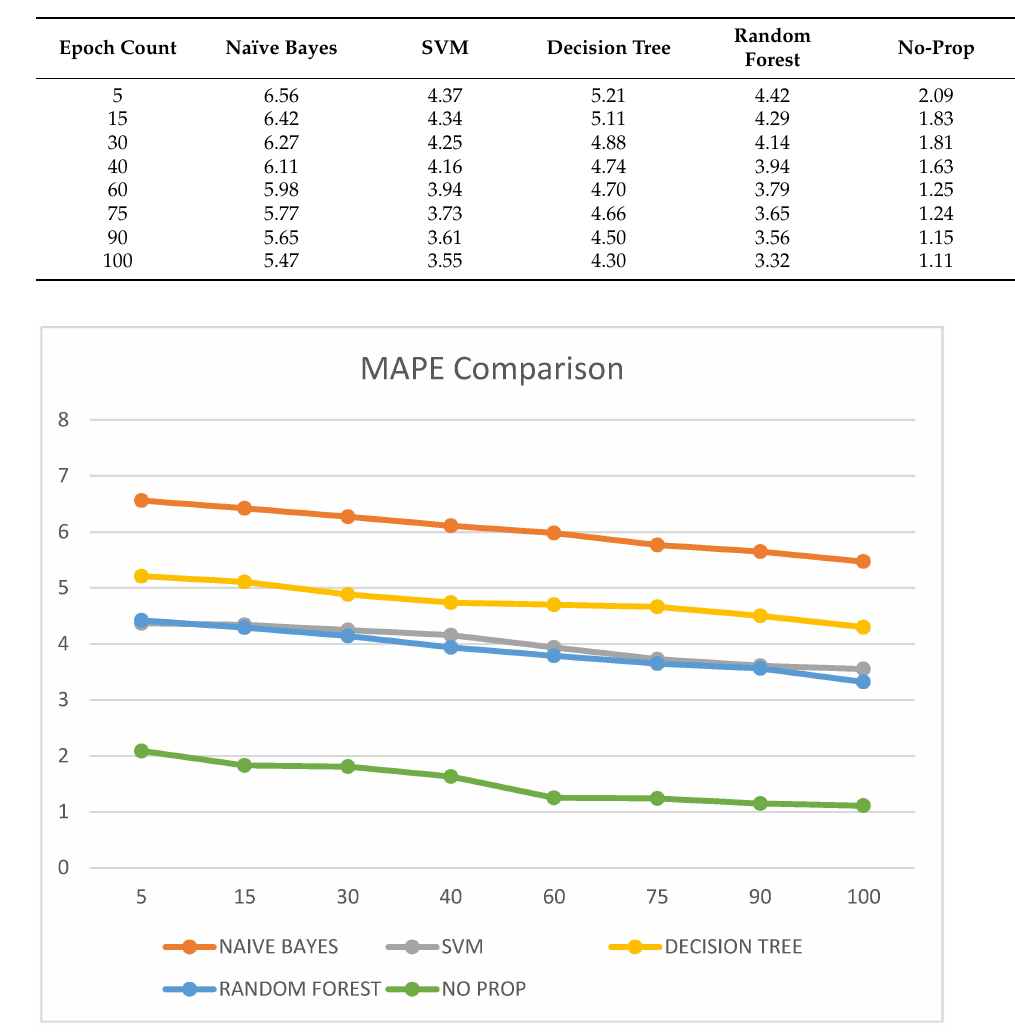
Table 6. MAPE comparison of different classification techniques at multiple epochs.